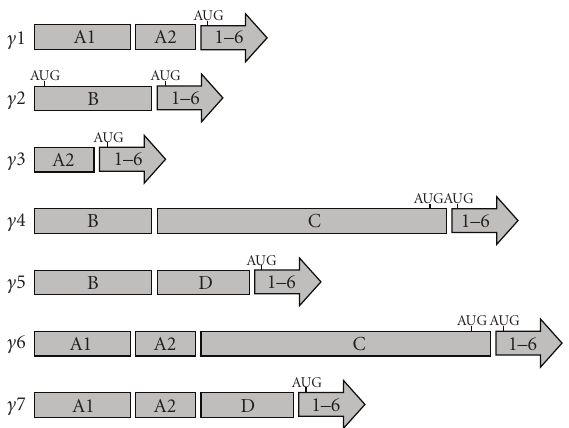
Figure 1: Structures of PPAR γ splice variants. Alignment of exons in seven PPAR γ mRNA splice variants is shown with 5 (cid:2) end on the left and 3 (cid:2) end on the right. The major translation initiation sites for each isoform are marked